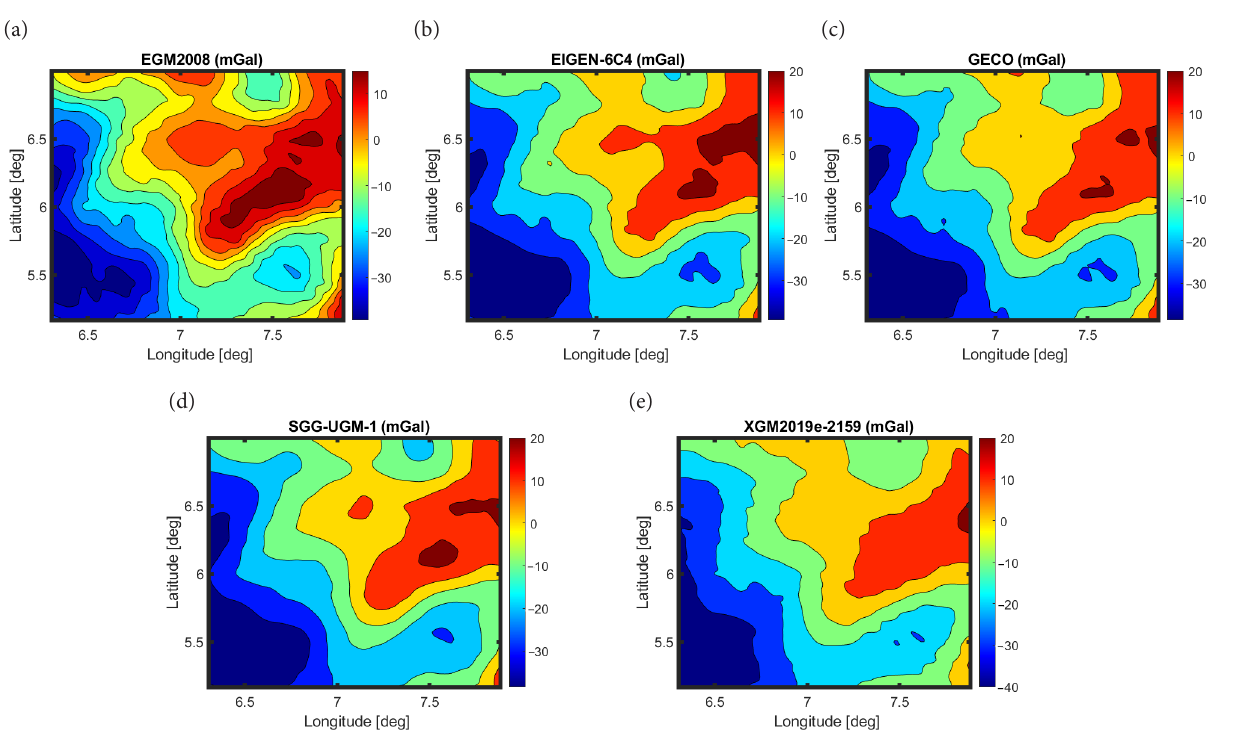
Figure 9. GGM-derived Bouguer gravity map of the Anambra Basin: